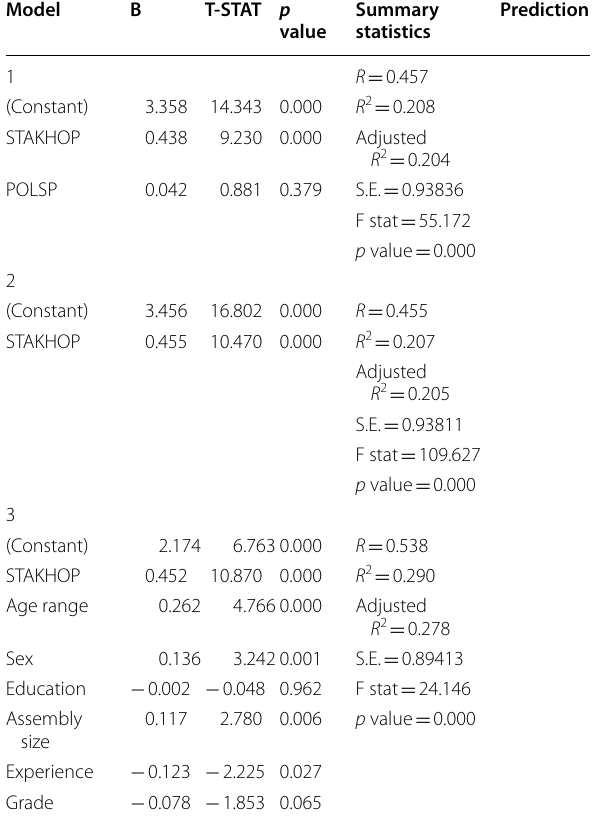
Table 6 Correlation matrix of organizational environment antecedents and PM